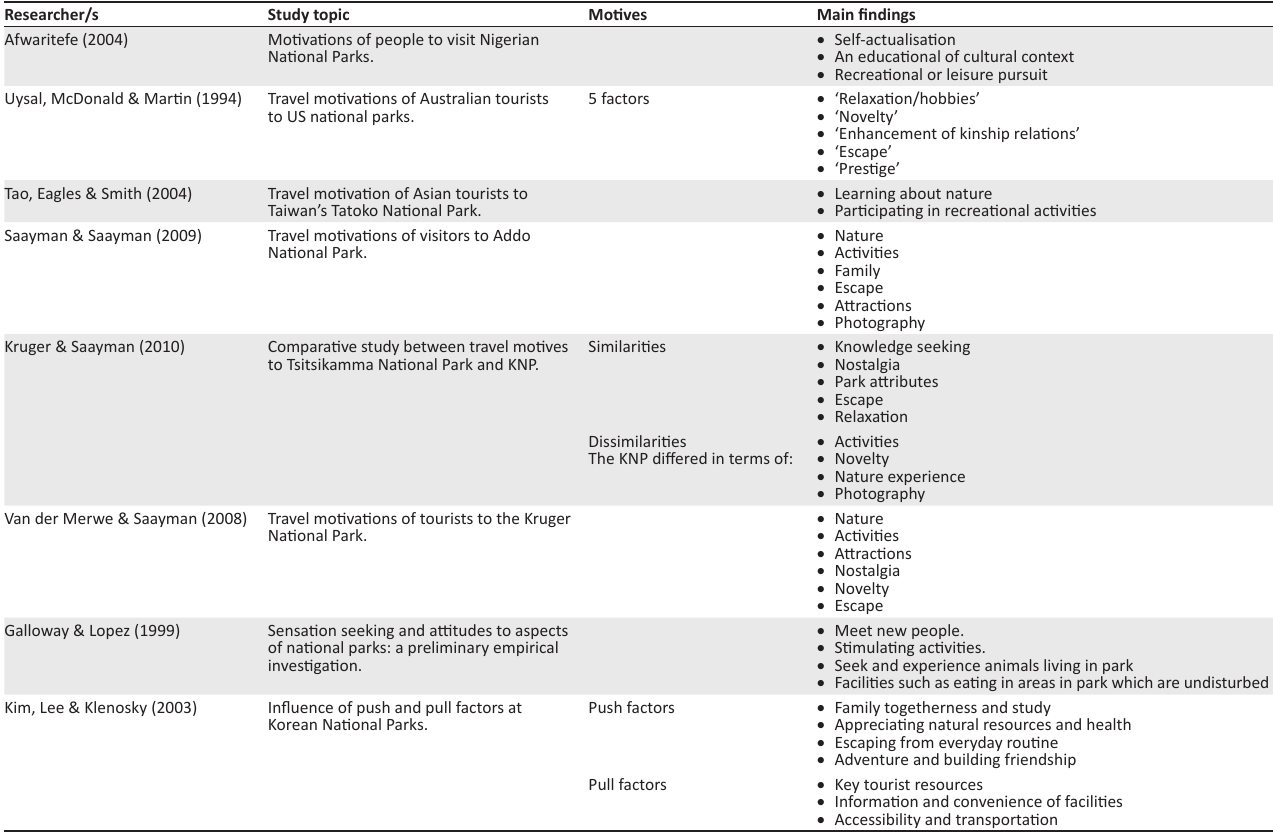
TABLE 1: Analysis of previous research on travel motives.